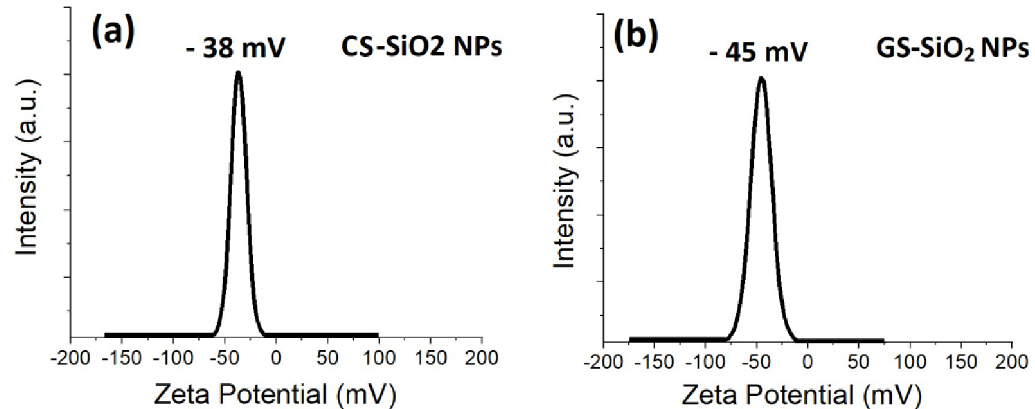
Fig 9. Zeta potential for (a) CS-SiO 2 NPs and (b) GS-SiO 2 NPs.